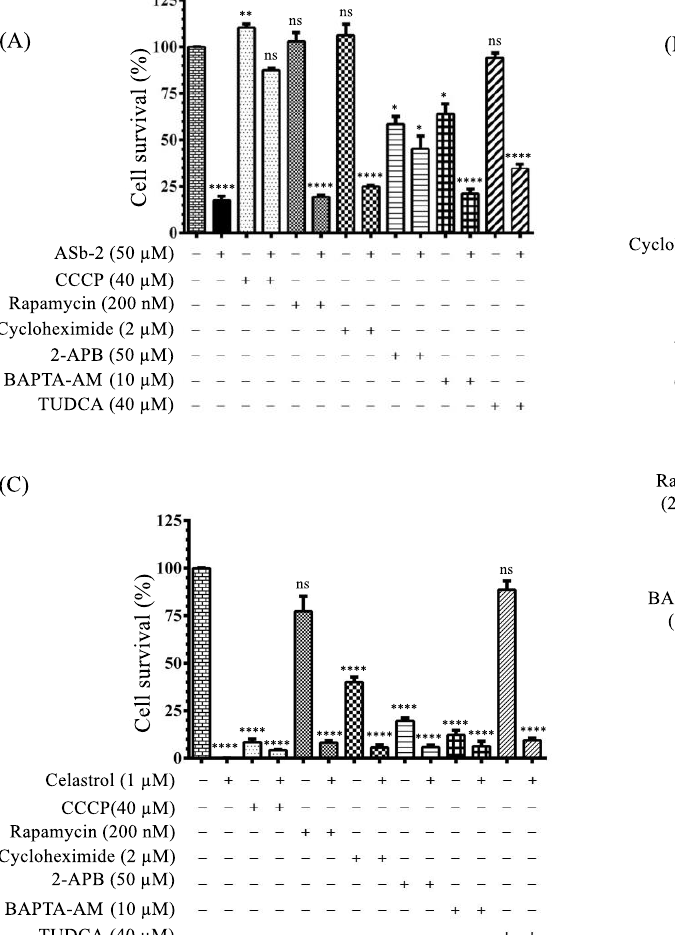
Figure 5. ( A ) The results (cell survival) of MTT assays of Jurkat cells treated with ASb-2 (50 µM) in the presence of CCCP (40 µM), rapamycin (200 nM), cycloheximide (2 µM), 2-APB (50 µM), BAPTA-AM (10 µM), and TUDCA (40 µM) for 1 h at 37 °C. ( B ) Typical microscopy images (Biorevo, BZ-9000, Keyence) of Jurkat cells treated with ASb-2 (50 µM) in the presence of CCCP (40 µM), rapamycin (200 nM), cycloheximide (2 µM), 2-APB (50 µM), BAPTA-AM (10 µM) and TUDCA (40 µM) for 1 h at 37 °C. Scale bar: 20 µm ( C ) The results of MTT assays of Jurkat cells treated with celastrol in the presence of CCCP (40 µM), rapamycin (200 nM), cycloheximide (2 µM), 2-APB (50 µM), BAPTA-AM (10 µM) and TUDCA (40 µM) for 24 h at 37 °C. * p < 0.05, ** p < 0.01, and **** p < 0.0001 indicate significant differences from the control. ns: no significant (the statistical data in Figure 5A,C are listed in Table S2 in the Supporting Information) .